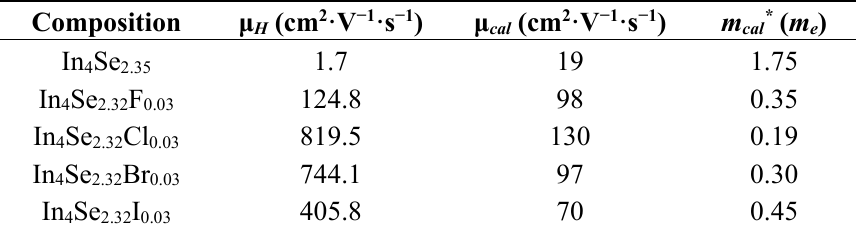
Table 7. Room temperature properties of In 4 Se 2.35 and In 4 Se 3 − x H 0.03 ( x = 0.68; H = F, Cl, Br,